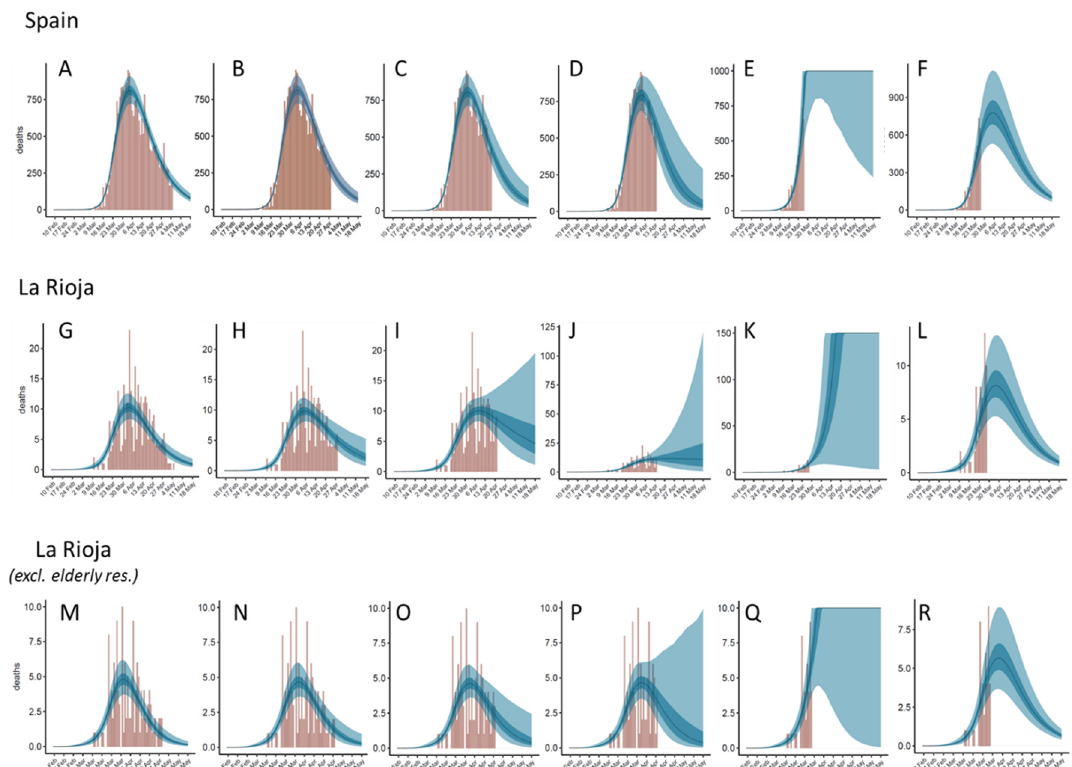
Figure 6. Estimated deaths for Spain (upper row) and La Rioja (total data: middle row; excluding elderly residences: bottom row) derived from the model ( A , G , M ) in comparison to the predictions obtained after removing the last week ( B , H , N ), last 2 weeks ( C , I , O ), last 3 weeks of data ( D , J , P ) or keeping data just up to 1 week to the peak ( E , K , Q ), the latter also after keeping constant R t = 0.625 ( F , L , R ).